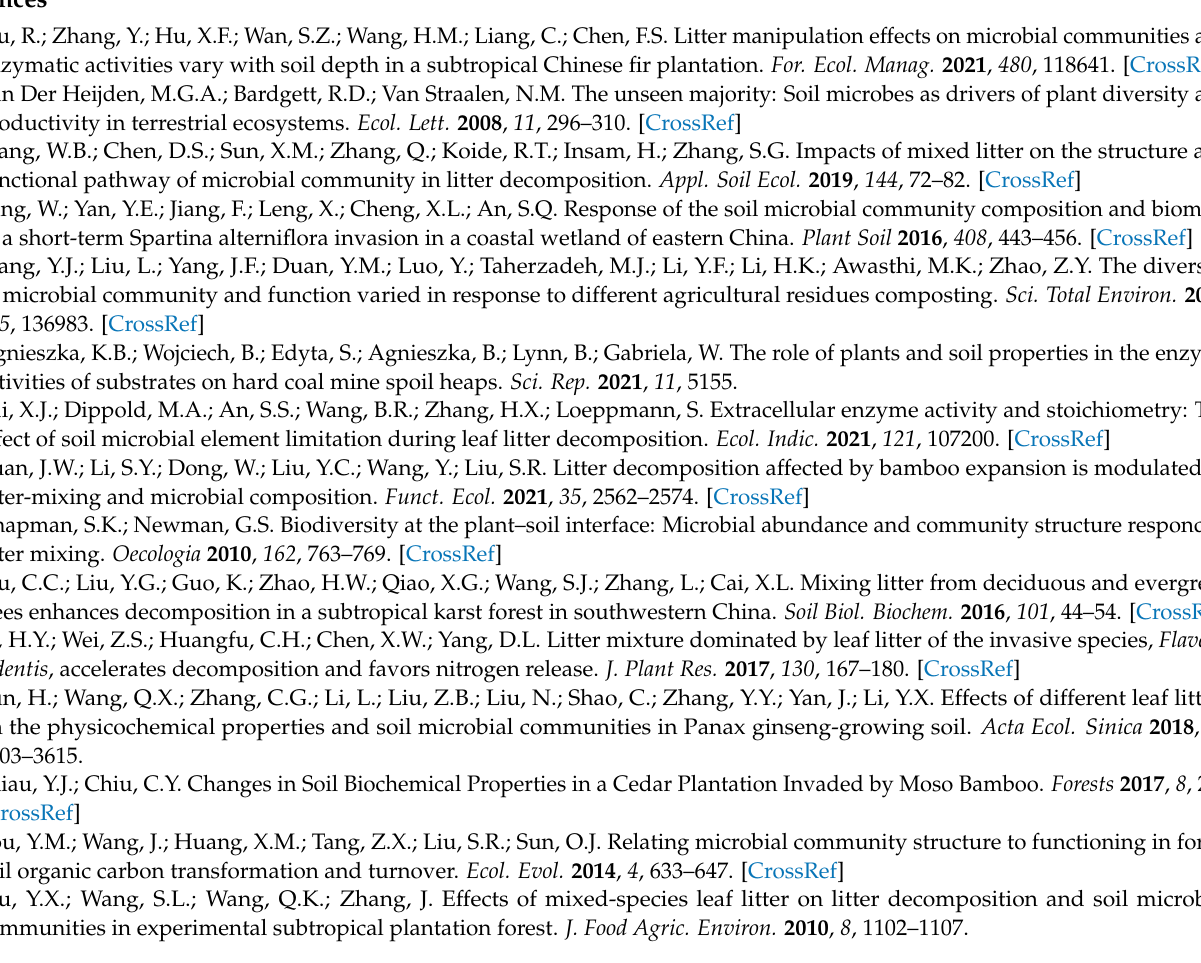
Table S1: Treatment effects on soil chemical properties during the